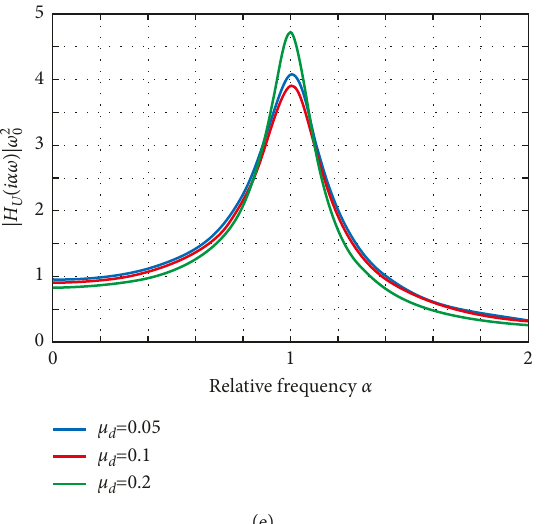
� 0.05; (c) μ � 0.1; (d) μ � 0.2; (e) displacement amplification d ; (b) μ d d d